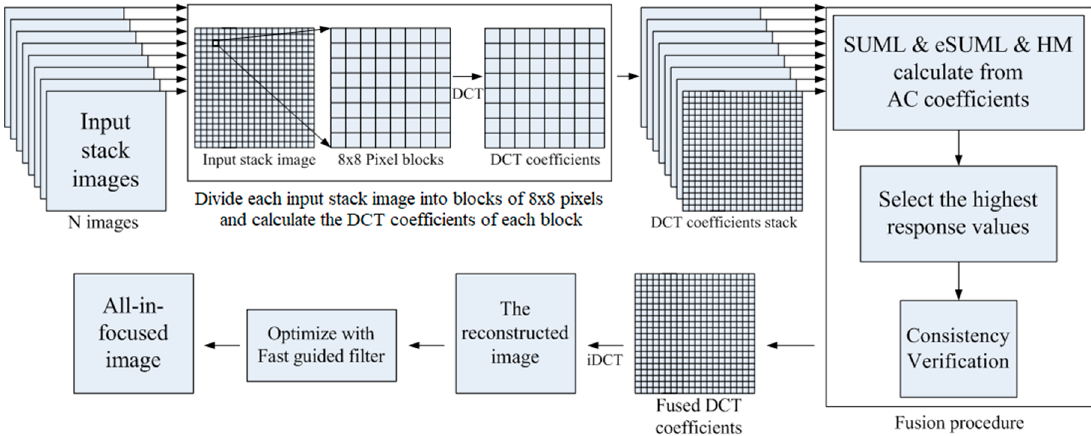
Figure 1. The procedure of the proposed method.